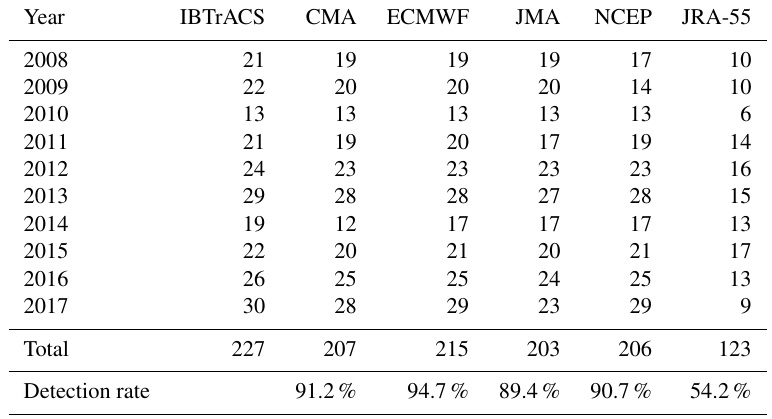
Table 4. From the left: annual number of historical TCs in IBTrACS (second column), annual number of historical TCs detected in the respective forecast models (third to sixth columns), and annual number of historical TCs detected in JRA-55 (seventh column).